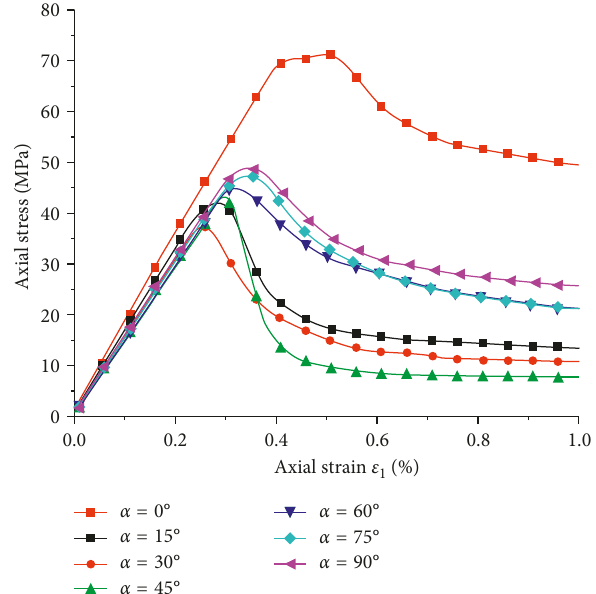
Figure 16: Stress-strain curves for each specimen under uniaxial compression.